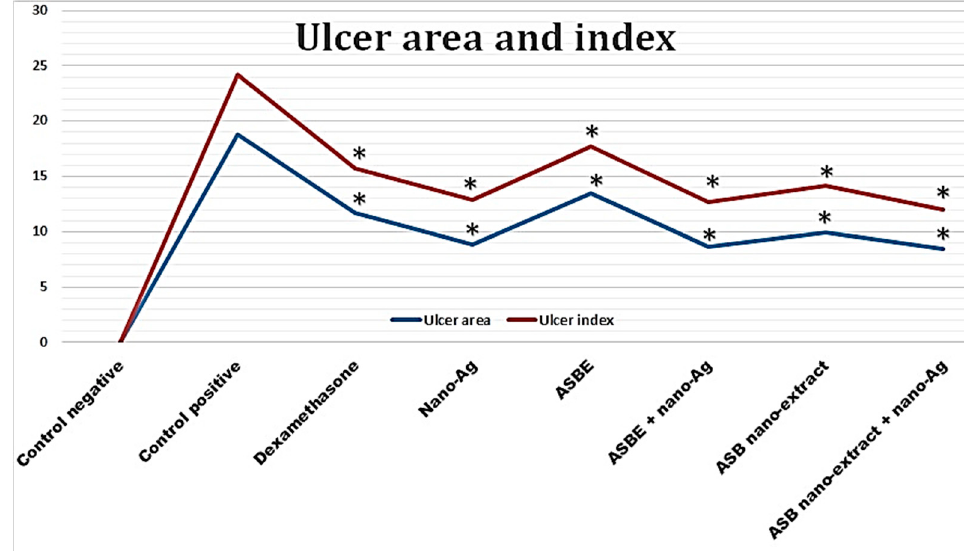
Figure 3. Effect of ASBE and its nano-extracts and their combination with nano-Ag on colon ulcer indices. Results are presented as mean ± S.E.M (n = 6). Statistical analysis was performed using one-way ANOVA followed by Tukey test. * Statistically significant from control positive at p < 0.05.